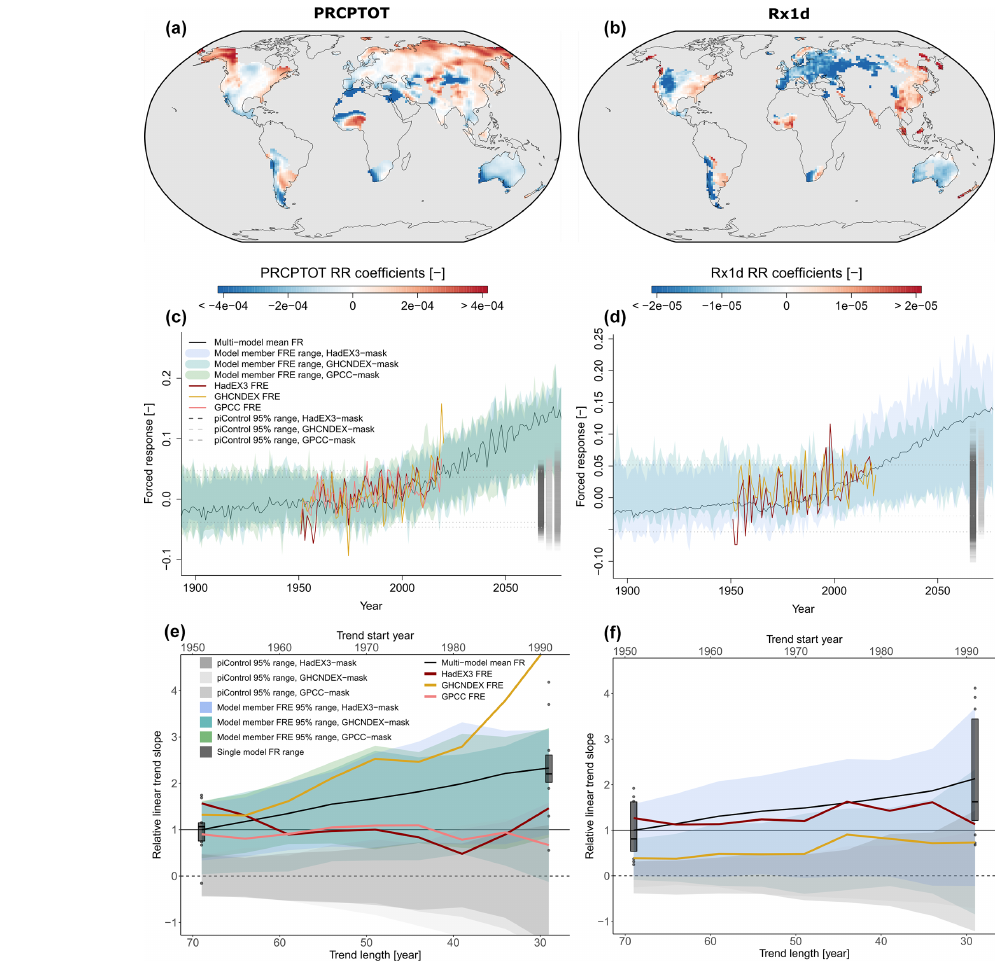
Figure 4. As Fig. 3 but for detrended predictors. Detrending implies removing the masked, area-weighted spatial mean from the model member data and observational data for each time